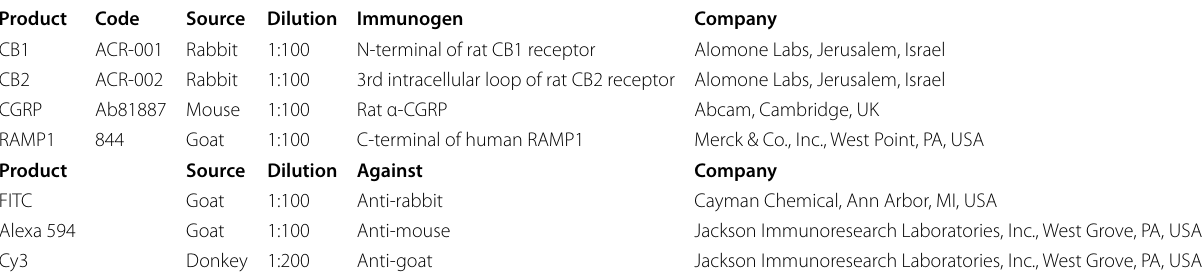
Table 1 Primary and secondary antibodies used